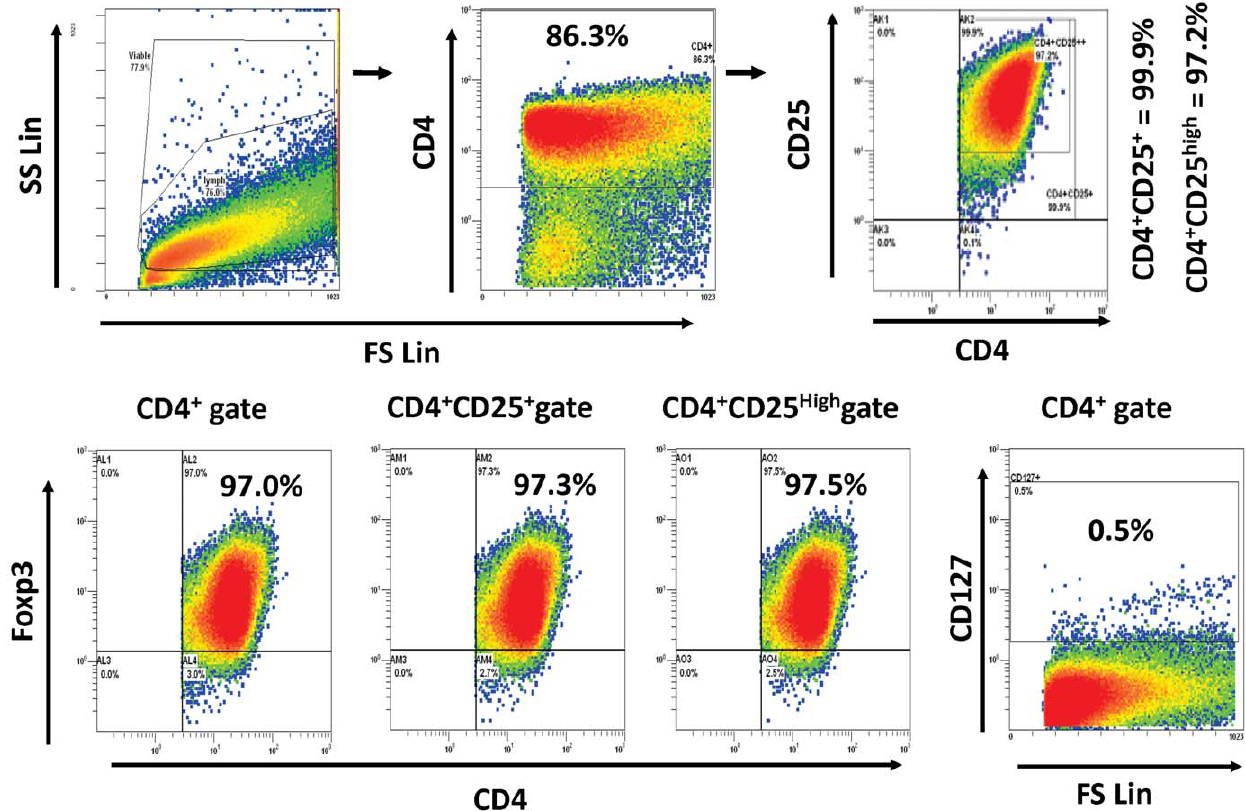
Figure 2. Purity and FOXP3 expression of MLR-Tregs. PBMCs from a healthy volunteer were stimulated with irradiated PBMC from an HLA fully mismatched donor. After 7 days, the CD4 + CD127 2 CD25 + cells were isolated by the Treg isolation kit (methods). These cells were designated as MLR- Tregs. The purity of the isolated cells was assessed for the indicated markers by flow cytometry. The gating strategy is indicated by arrows and title headings on histograms. Thus, the viable cells (top left) were gated based on forward scatter and side scatter and then on CD4 + cells (top middle) followed by CD25 + or CD25 high expression (top right). The FOXP3 and CD127 levels were then assessed on indicated gates (bottom). These dot plots depict 1 example of . 30 experiments performed in this report.